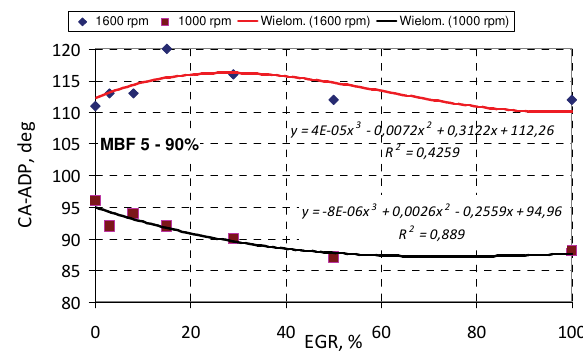
Fig. 15. Impact of EGR opening at duration of MBF 5% - 90 % value